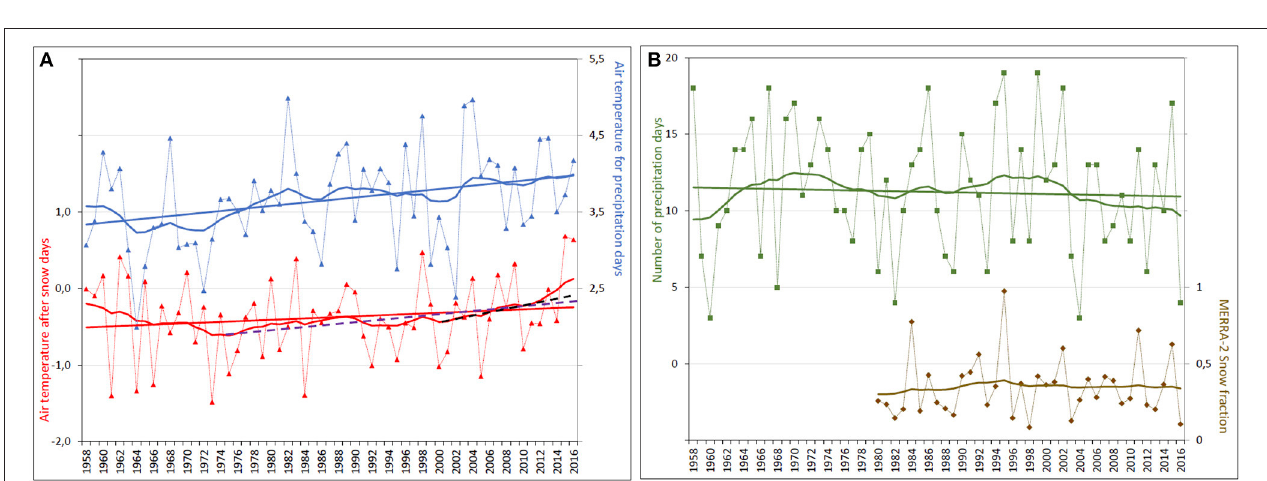
FIGURE 11 | Climate indices and snow cover at Brunswick Peninsula after smoothing the interannual variability using an exponential filter. The straight light blue line is the linear trend of the snow cover. SOI: Southern Oscillation Index (red), AAO: Antarctic Oscillation Index (green), PDO: Pacific Decadal Oscillation Index (black). Z macro (blue) is the snow cover extent (km2) on the study area (Brunswick Peninsula).